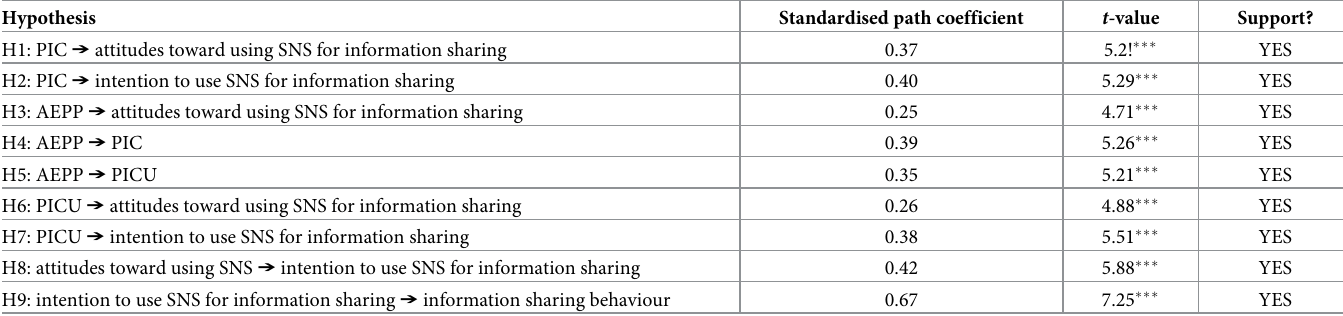
Table 6. Path coefficients and t-values for the whole